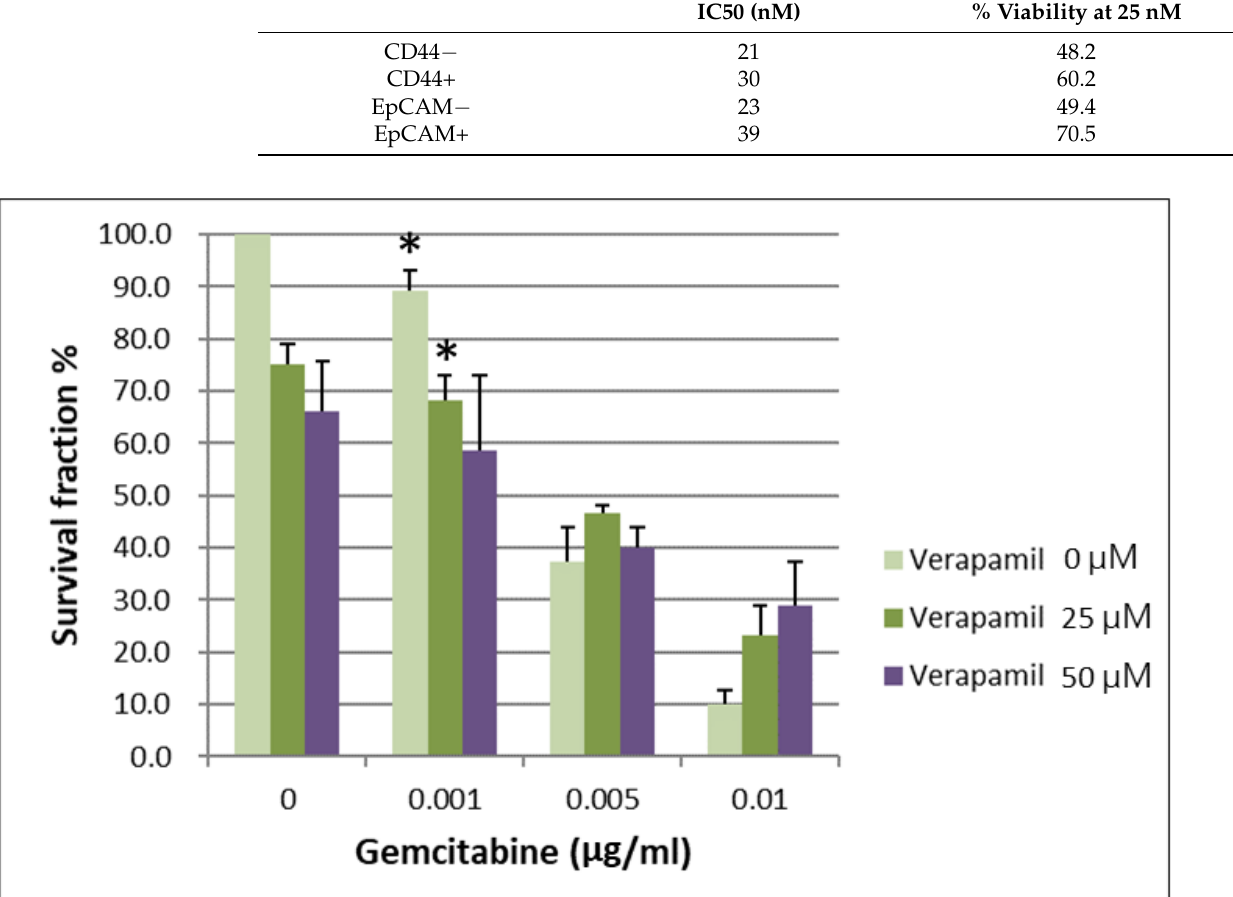
Figure 3. The survival of parental BxPC-3 PDAC cells treated with different concentrations of verapamil and gemcitabine is shown. Verapamil 25 and 50 µM exerted the best chemotherapeutic effects when gemcitabine concentration of 0.001 µg/mL was used, * < 0.05. (Mean ± SD).